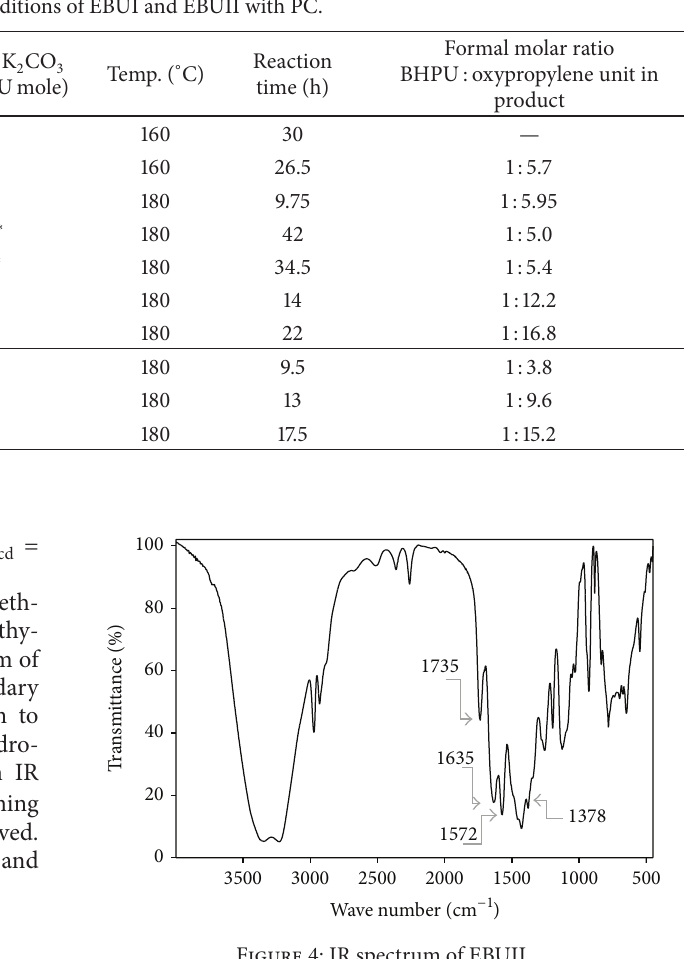
Figure 4: IR spectrum of